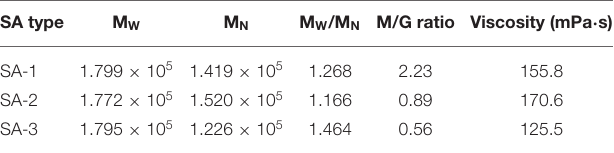
TABLE 1 | Results of determination of physical and chemical properties of SA. SA